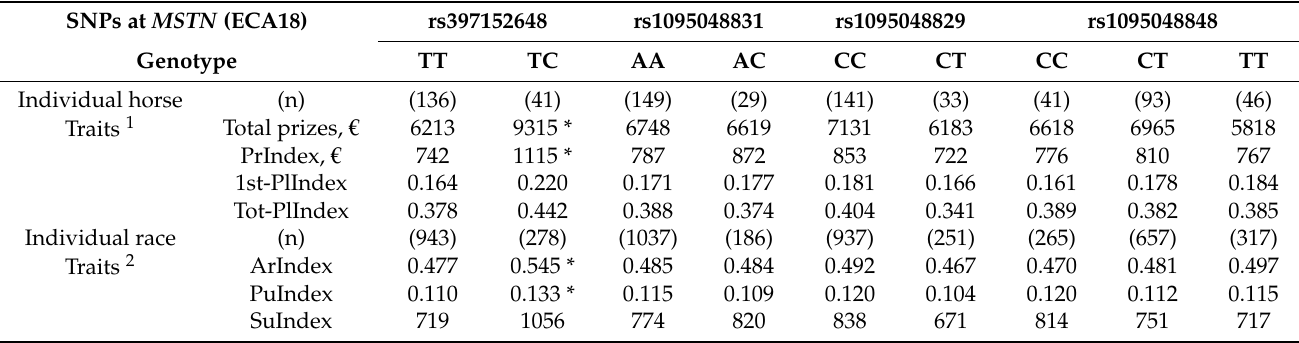
Table 4. Least square means of sporting performance traits of the individual horse and race according to the SNPs genotypes at equine MSTN gene (SNP with minimum allele and genotype frequencies higher than 0.05, one SNP at a time); samples from 180 Anglo-Arabian horses running 1239 races in their debut year (three year of age). SNPs at MSTN